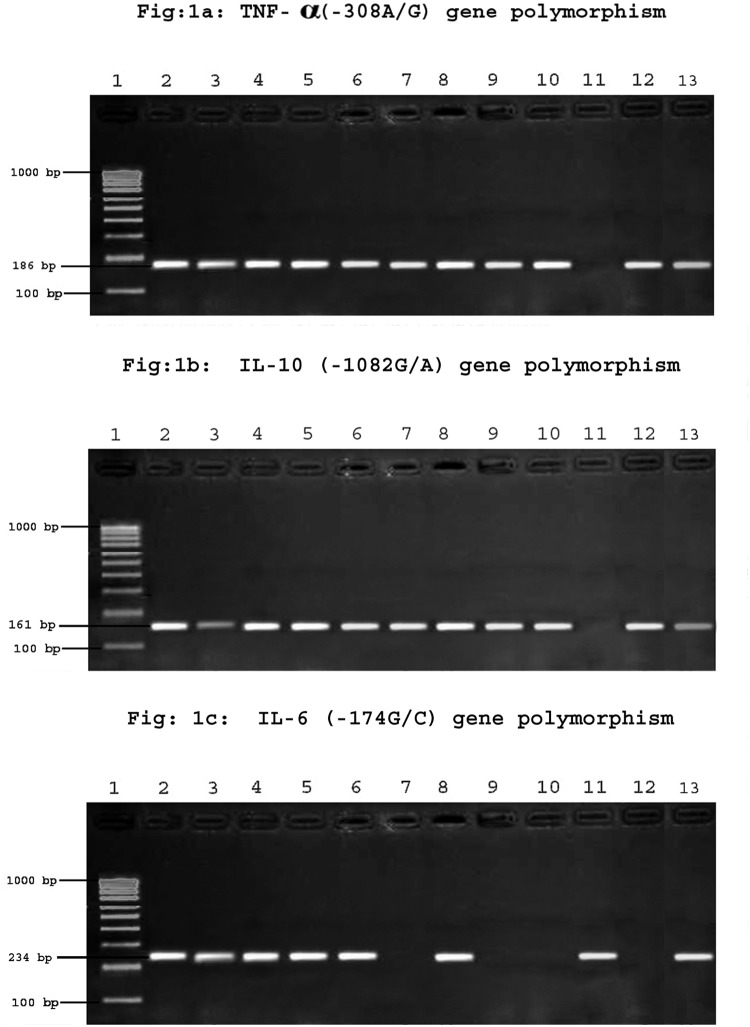
TNF-α (-308A/G), IL-10 (-1082G/A), IL-6 (-174G/C) gene polymorphism.(1a) Lane 1–100 bp ladder;Lane 2–3;4–5;6–7;8-912-13-GA genotype; 10-11-GG genotype; respectively.(1b) Lane 1 – 100bp Ladder; Lane 2 &3 to 8& 9 –GA genotype; Lane 10&11 to 12&13 –GG genotype.(1c) Lane 100- 1000bp ladder;Lane 2-3-GC; 4-5-GC; 6–7,8-9-GG;10-11-CC;12-13-CC genotype.